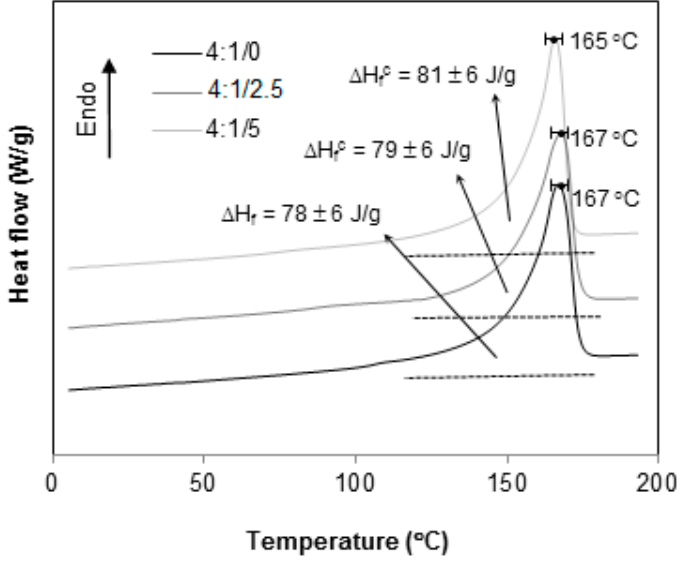
Figure 13. DSC thermograms for 4:1 PP/HIPS blends with 0, 2.5 and 5 phr of CNSL.